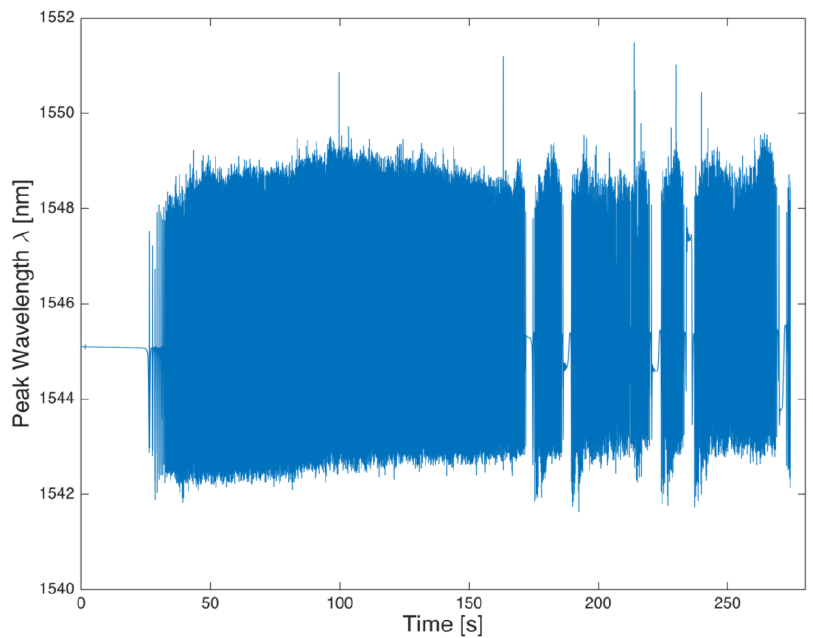
Figure 21. FBG wavelength log for a random speed straight run.